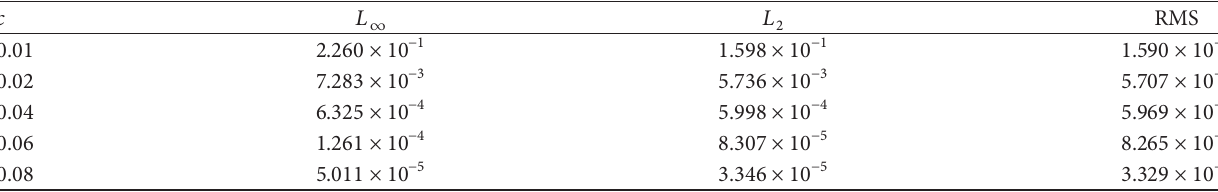
Table 4: Numerical errors using IMQ represented with different parameter 𝑐 at time 𝑡 = 2 , where 𝑑𝑥 = 0.01 , 𝑑𝑡 = 0.001 , and 𝜃 = 1/2 . 𝑐